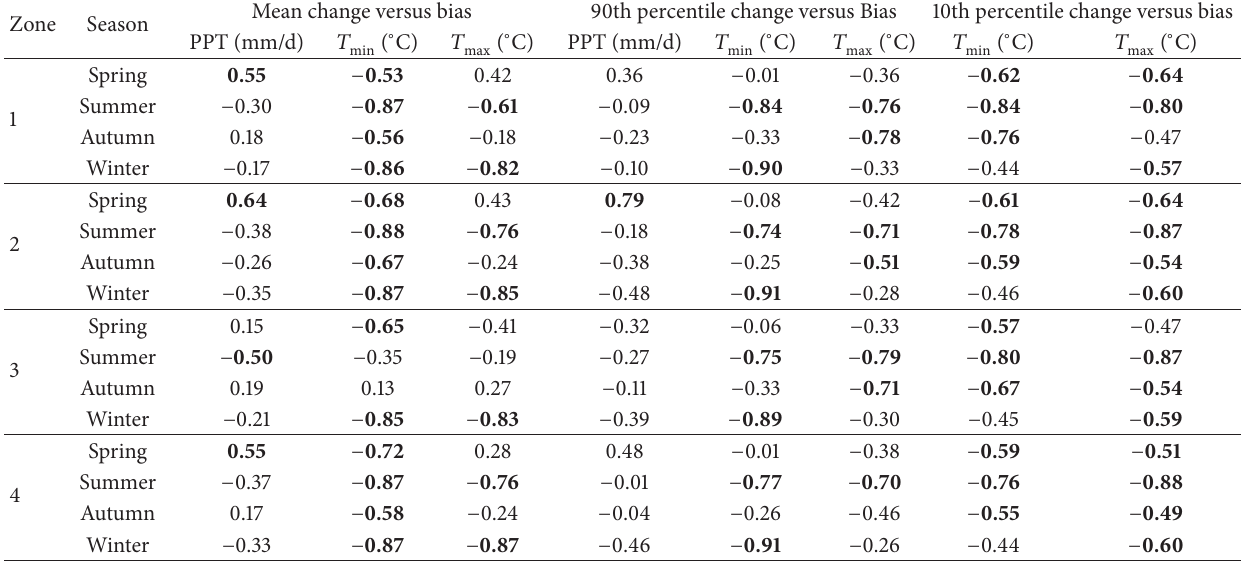
Table 2: Intermodel correlation between simulated change and bias for seasonal mean precipitation and temperatures. Precipitation (PPT), 𝑇 𝑇 min , and max represent precipitation, minimum temperature, and maximum temperature, respectively. Bold font in correlation coefficient represents the case in which the intermodel correlation is significant at the 90% confidence level (absolute values above |0.497| ). Each subregion or zone (from 1 to 4) represents each subarea (SW, NW, SE, and NE, resp.) defined in Figure